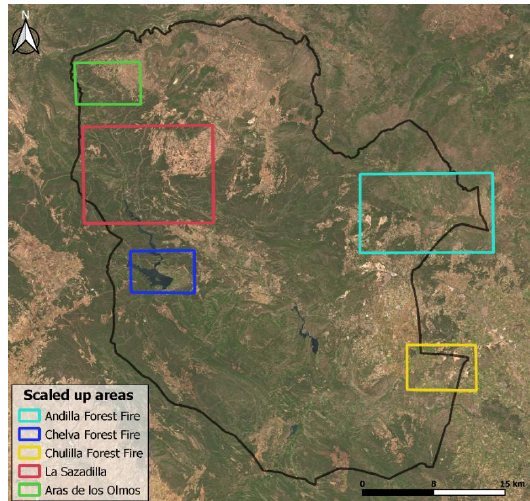
Figure 4. GHG emission risk scale-up areas.